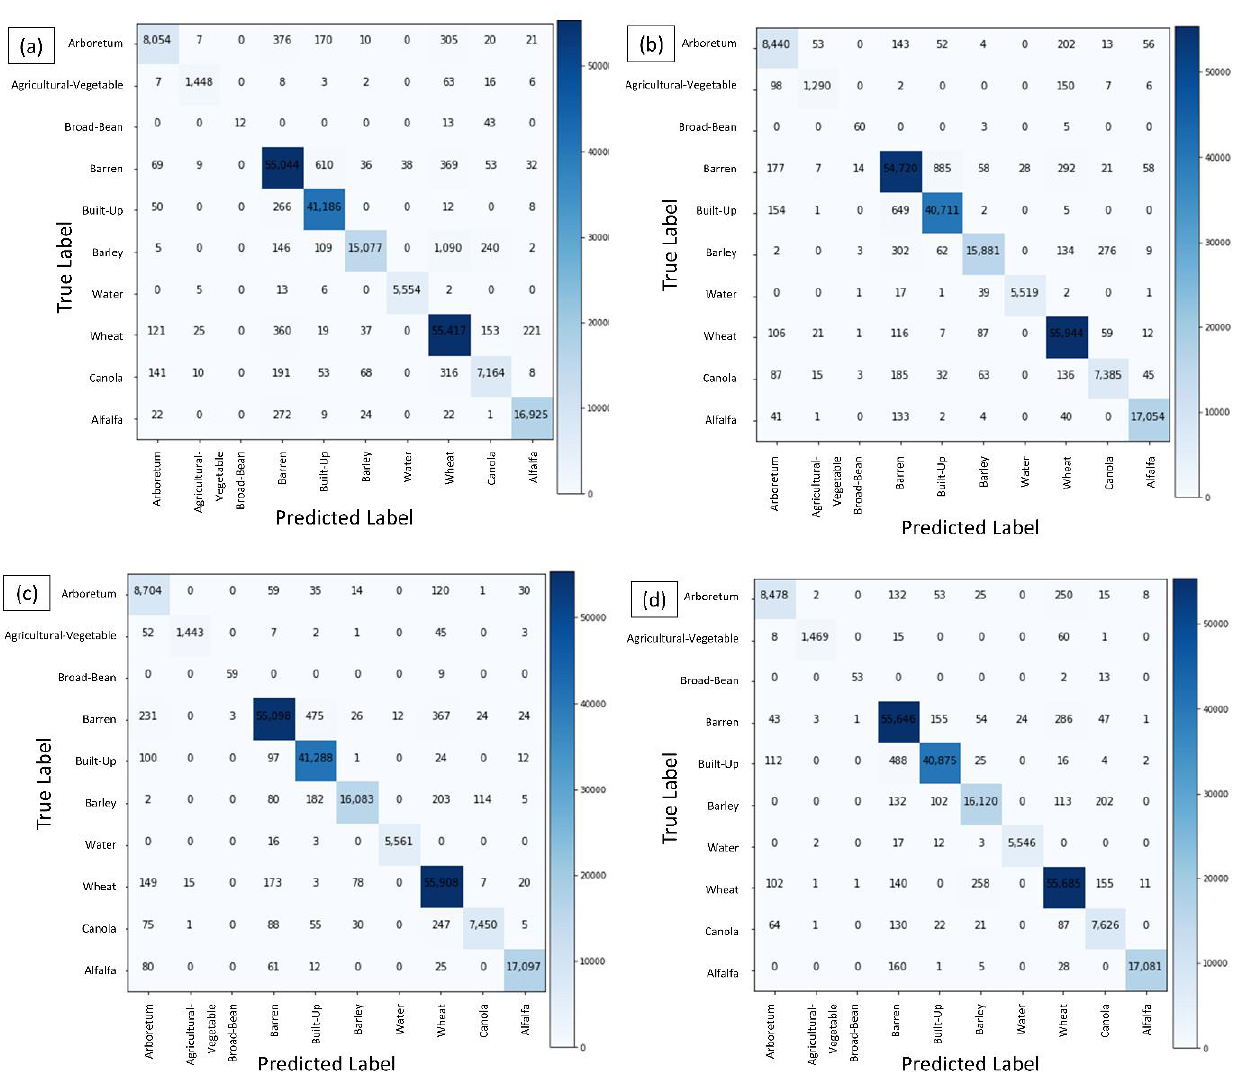
Figure 10. Ablation analysis of the proposed method: ( a ) without attention block, ( b ) without spectral attention block, ( c ) without spatial attention block, and ( d ) proposed method with all functions.